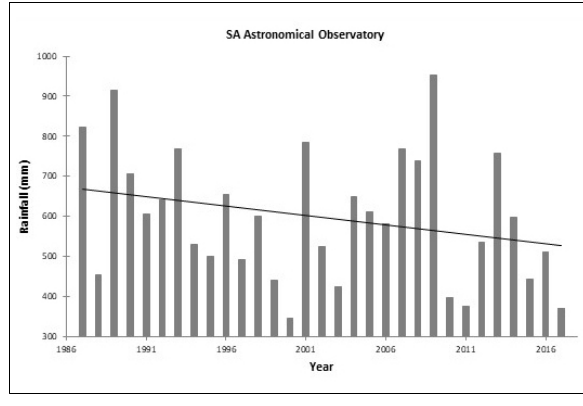
Statistically significant decreasing annual rainfall at the SA Astronomical Observatory station over the period